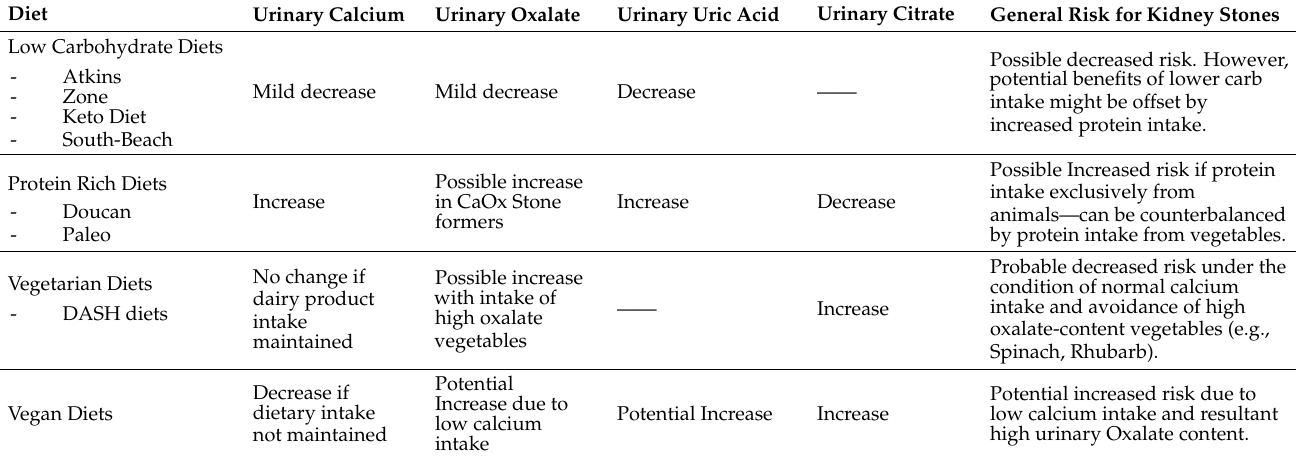
Table 1. Summary of diets and potential effect on urinary parameters (Carb: Carbohydrates, CaOx: Calcium